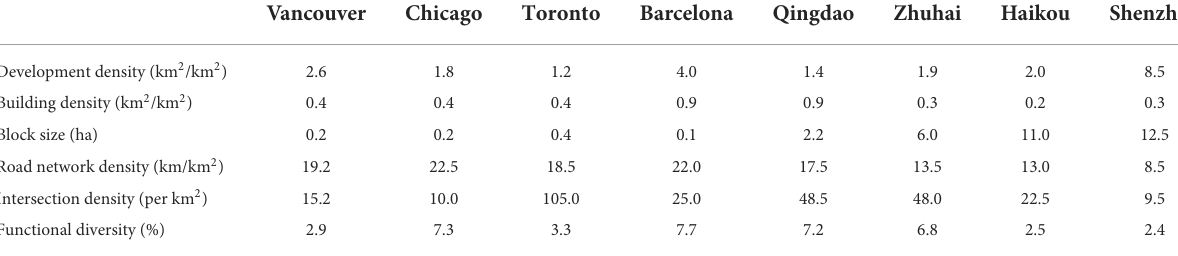
TABLE 3 The summary of quantitative analysis results of the selected eight case study coastal zones. Vancouver Chicago Toronto